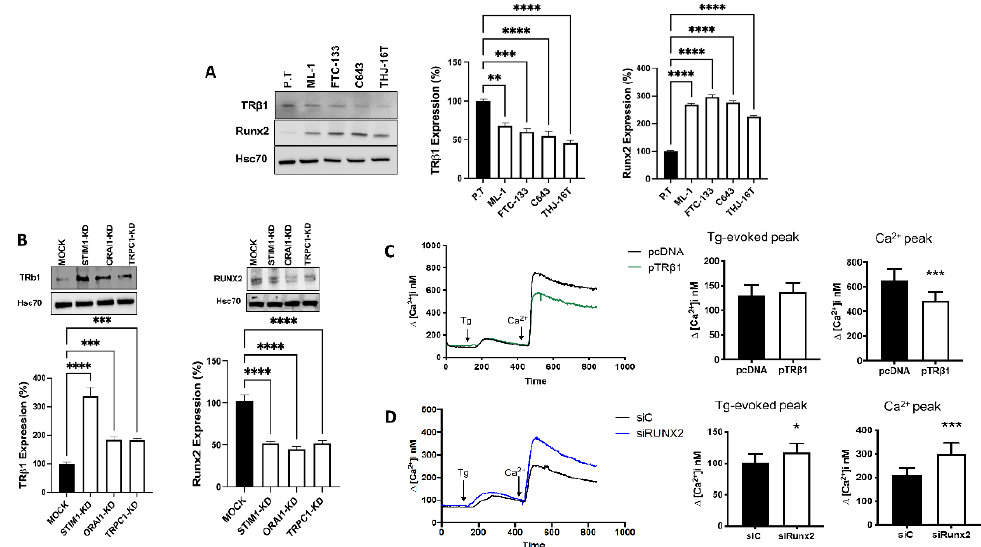
Figure 3. TR β 1 and Runx2 expression in normal and thyroid cancer cell lines and effects on store-operated calcium entry. ( A ), Expression of TR β 1 and Runx2 in thyroid cancer cell lines compared to normal human primary thyroid epithelial cells (P.T). ( B ), Protein expression of TR β 1 and Runx2 in shRNA expressing (MOCK), shRNA STIM1 expressing (STIM1-KD), shRNA ORAI1 expressing (ORAI1-KD) and shRNA TRPC1 expressing (TRPC1-KD) cells by Western blotting. Hsc70 was used as a loading control. The bar diagrams show the mean ± SEM ( n = 3). ** p < 0.01, *** p < 0.001, **** p < 0.0001. ( C ), Representative trace showing changes in intracellular calcium when TR β 1 overexpressing ML-1 cells (pTR β 1) and control cells (pcDNA) in calcium-free buffer were treated with Thapsigargin (Tg, final conc. 1 µM) and when calcium was re-added (final conc. 1 mM). The left bar diagram shows the magnitude of the Tg-evoked peak in intracellular calcium, and the right bar diagram shows the magnitude of the changes in intracellular Ca 2+ after calcium was re-added to the Tg-treated cells. The bars show the mean ± SEM of 35 cells. *** p < 0.001. ( D ), Representative trace showing changes in intracellular calcium in Runx2 silenced ML-1 cells (siRunx2) and control cells (siC) in calcium calcium-free buffer when treated with Thapsigargin (Tg, final conc. 1 mM) and when calcium was re-added (final conc. 1 mM). The left bar diagram shows the magnitude of the Tg-evoked peak in intracellular calcium, and the right bar diagram shows the magnitude of the changes in intracellular calcium after calcium was re-added to the Tg-treated cells. The bars show the mean ± SEM of 50 cells. * p < 0.05, *** p < 0.001.